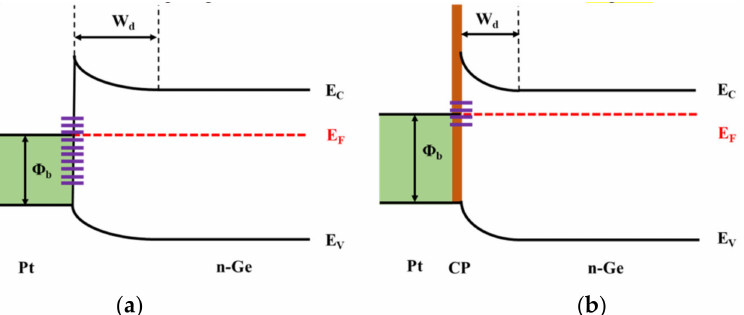
Figure 6. Energy band diagrams for Pt/n-Ge Schottky diodes ( a ) with and ( b ) without a CP